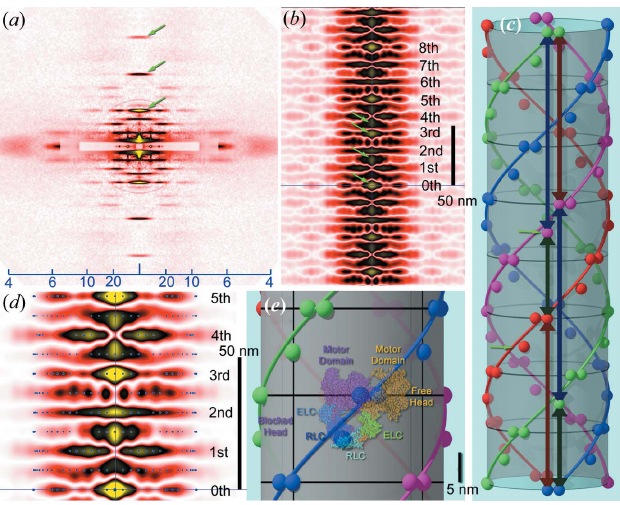
Figure 3 Reconstruction of the 3D structure of myosin filament from an actually recorded diffraction pattern. ( a ) A diffraction pattern from actin- extracted bumblebee flight muscle fibers. The arrows indicate meridional reflections from myosin-head crowns. ( b ) The CAP calculated from the diffraction pattern in ( a ). The numbers indicate the levels of the 14.5 nm crowns of myosin heads. The arrows indicate the peaks on the z axis at the 1.5th, 3rd and 3.5th levels of myosin crowns. ( c ) The solved structure of the myosin filament. The black lines on the cylinder indicate the levels of crowns and the small arrows indicate the additional mass lying midway between two neighboring crowns. The green, red and blue double-headed arrows indicate the vertical vectors of 1.5, 3 and 3.5 (cid:4) 14.5 nm lengths, respectively. ( d ) Superposition of the actually observed CAP and the idealized CAP calculated from the solved structure (blue dots). ( e ) Superposition of the interacting-heads motif (Sweeney, 2018) and the three-mass unit on the solved structure. The size of the motif was adjusted by using the scale bar in the work of Alamo (2016) (right). The values on the scale bar in ( a ) are d spacings (nm).